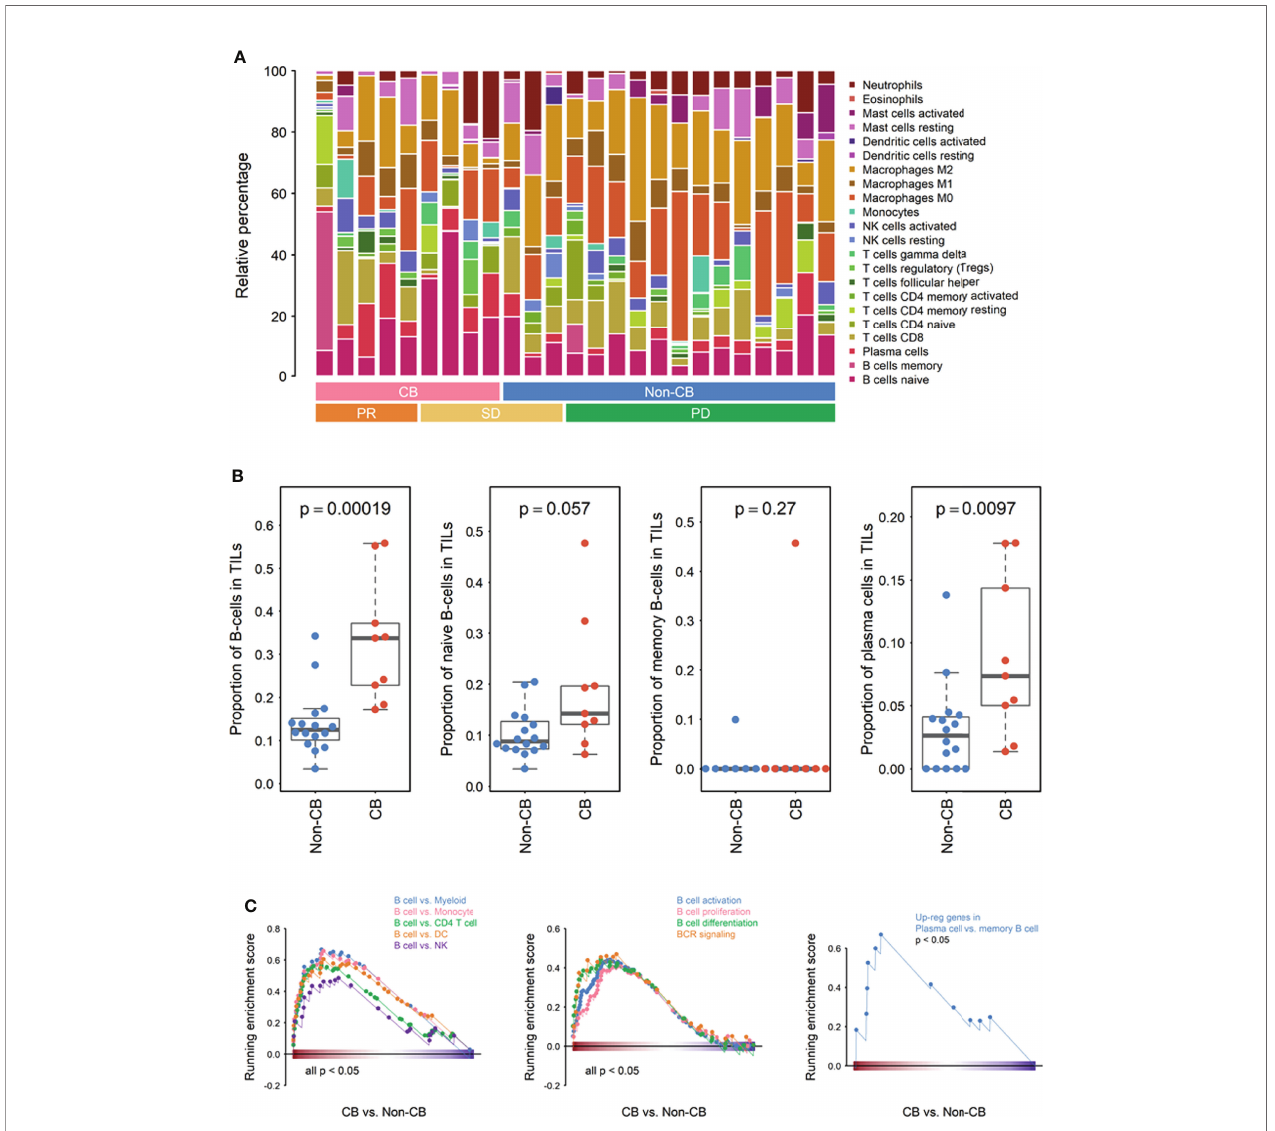
FIGURE 3 | Transcriptional analyses of immune cell subpopulations classi fi ed using CIBERSORT and differential immune-related pathways evaluated using Gene Set Enrichment Analysis (GSEA). (A) Relative percentage of immune cell subpopulations clustered based on clinical bene fi t (CB) (n = 16 non-CB and 9 CB) and response (PR, partial response; SD, stable disease; and PD, progressive disease). (B) Scatter plots demonstrating the percentage of B cells and B cell subpopulations as indicated between the CB (n = 9) and non-CB (n = 16) groups. (C) GSEA plots of immune cells, B cell function, and plasma cells compared with memory-B-cell-related genes expressed in CB (n = 9) and non-CB (n = 16)